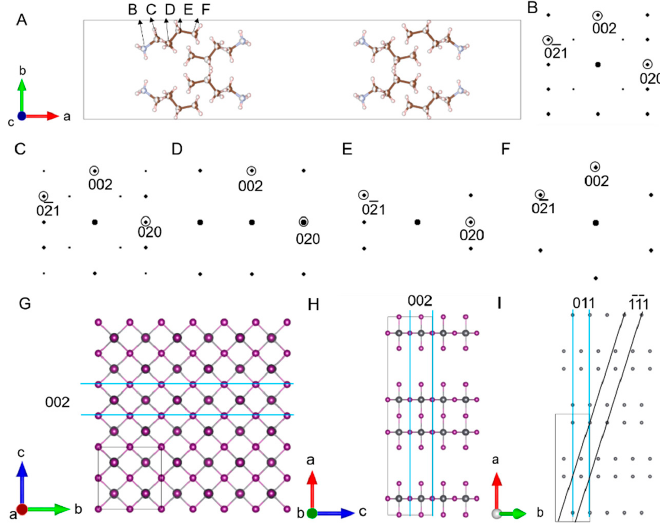
Figure 4. ( A ) The structural projection of the BA + section in [001] direction. ( B – F ) Corresponding simulated electron di ff raction of the frameworks from di ff erent nitrogen / carbon atoms. Gray and brown represent nitrogen and carbon atoms, respectively. ( G , H ) The structural projections of non-tilted [Pb 2 I 7 ] 3 − section in [100] and [010] direction, respectively. The blue lines represent the (002) plane. ( I ) The structural projection of Pb atoms in [011] direction. The blue line and the black line represent the (011) and (111)